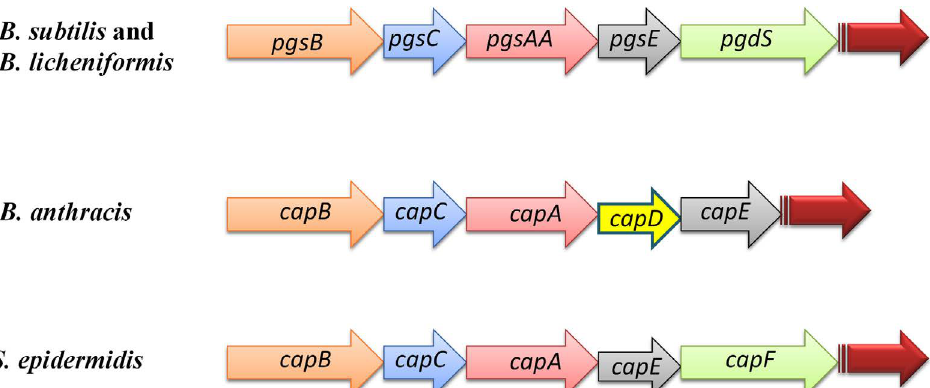
Fig. 2. Genetic assembly of B. subtilis, B. lichenisformis, B. anthracis and S. epidermidis required for PGA biosynthesis. Structures of PgsB (CapB) and PgsC (CapC) are similar to the cytosolic enzyme. PgsA (CapA) is analogous to the serine/threonine phosphatases. PgsE (CapE) stimulates PGA production. CapF of S. epidermidis is similar to B. anthracis enzyme. PgdS in B subtilis and B. licheniformis is an amidase